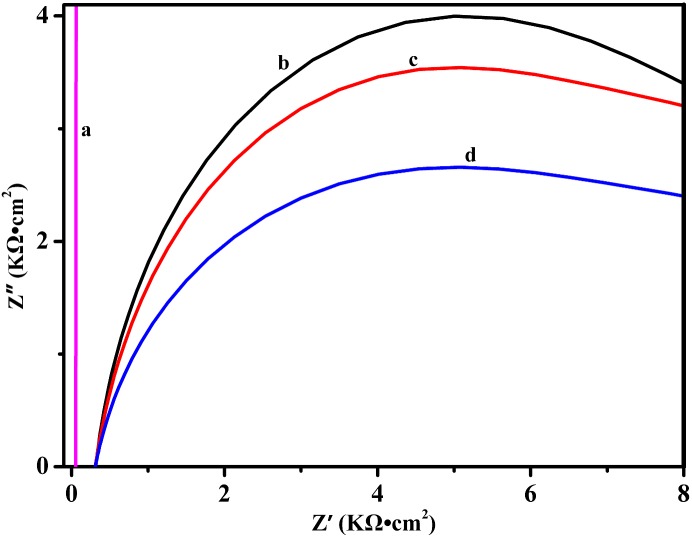
EIS of CuS-GeO2-TiO2 composite coating electrode (a) PureTiO2, (b) Dark, (c) Visible light, and (d) Ultraviolet light.